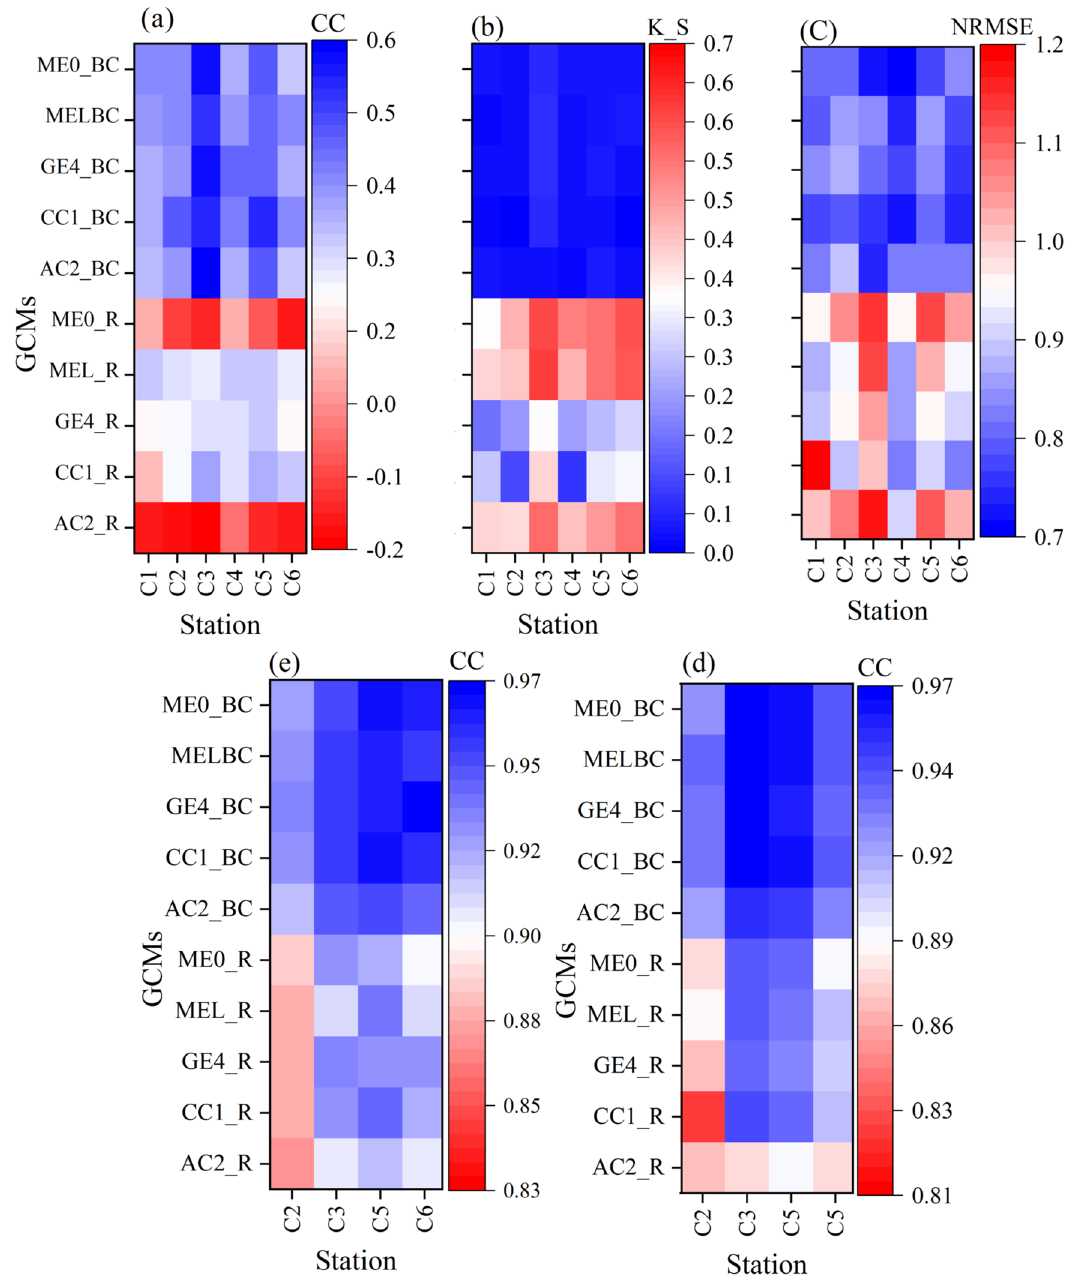
Figure 3. Summary of the statistical performance of raw General Circulation Model (GCM) (suffix _R), and bias-corrected GCM (suffix _BC), for monthly precipitation based on ( a ) the Kolmogorov–Smirnov statistics (KS), ( b ) correlation coefficient (CC) , and ( c ) normalized root mean square error (NRMSE). Summary statistics of the monthly performance of raw GCM (suffix _R) and bias-corrected GCM (suffix _BC) based on the CC for ( d ) minimum air temperature and ( e ) maximum air temperature (This figure was created in the Python 3.9 and the Jupyter notebook programming